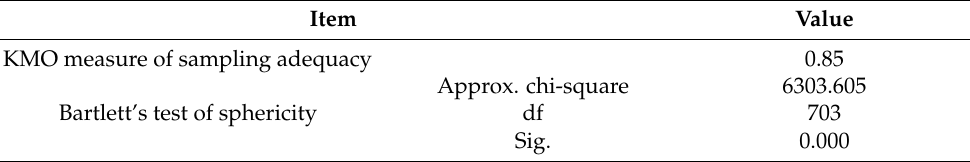
Table 3. KMO and Bartlett’s